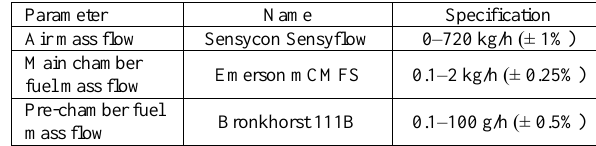
Fig. 4.View of 3D mixer model used in